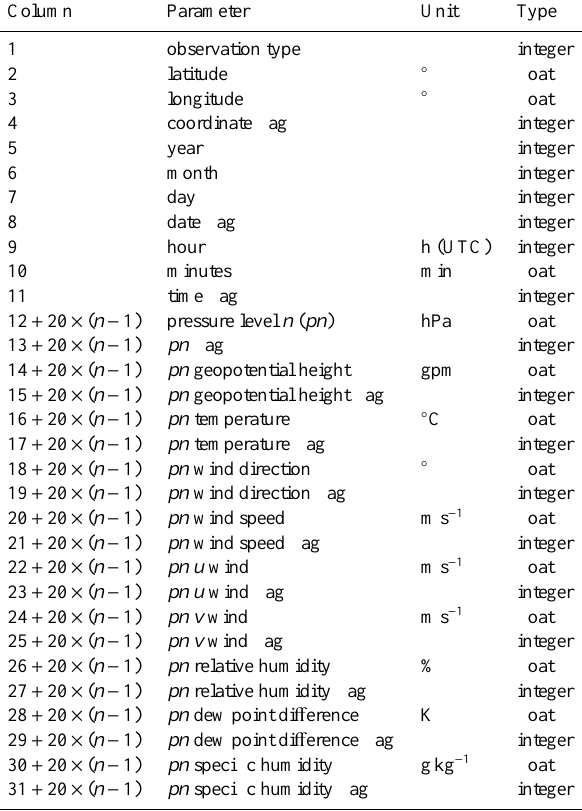
Table 5. Definition of the columns in the moving upper-air geo- metrical height level format ASCII files used for the ERA-CLIM data. Su ffi ces .1 / .2 added to flag values signify observation values obtained during ascent / descent of a kite or tethered balloon (see Ta- ble 7). n runs from 0 to 100.